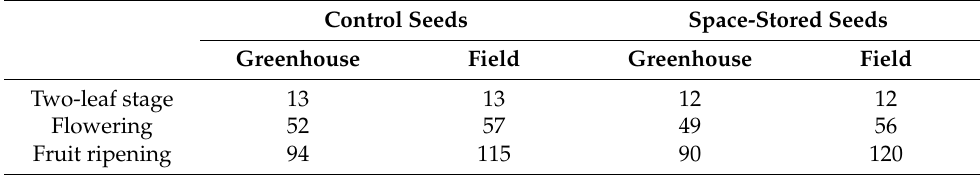
Table 1. Phenological progress of tomato plants grown in greenhouse and in open field, from control and spaceflight-exposed seeds, expressed as days from sowing referring to 50% of plants that reached each stage.